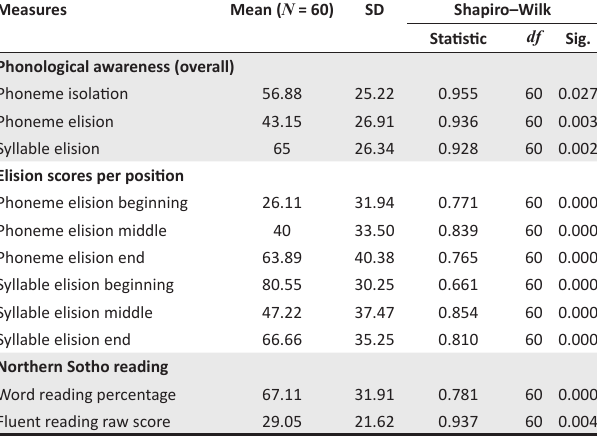
TABLE 1: Mean percentages (for phonological awareness measures and word reading), mean raw score (for fluent reading), standard deviations and normality